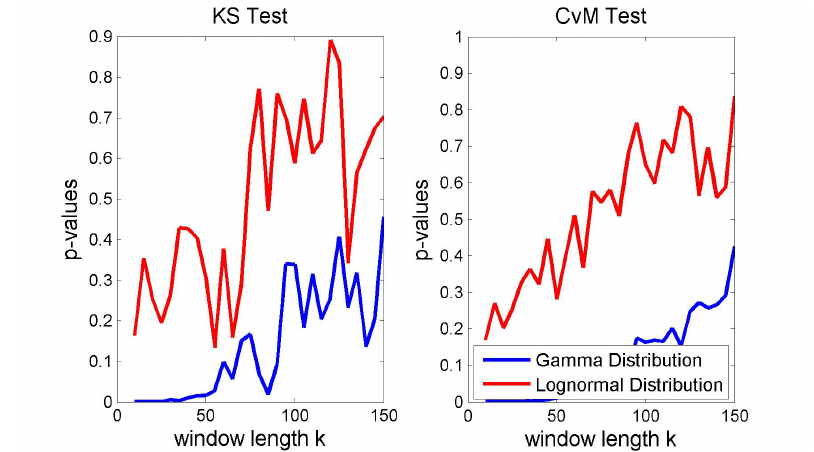
Figure 6. Different measures of fit for volatility.